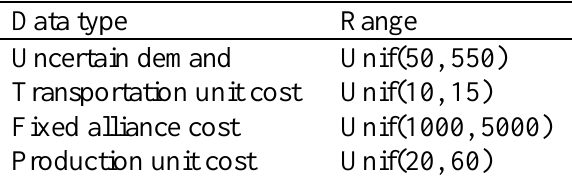
Fig 1. SCN for the example Table 1. Data used in the problem